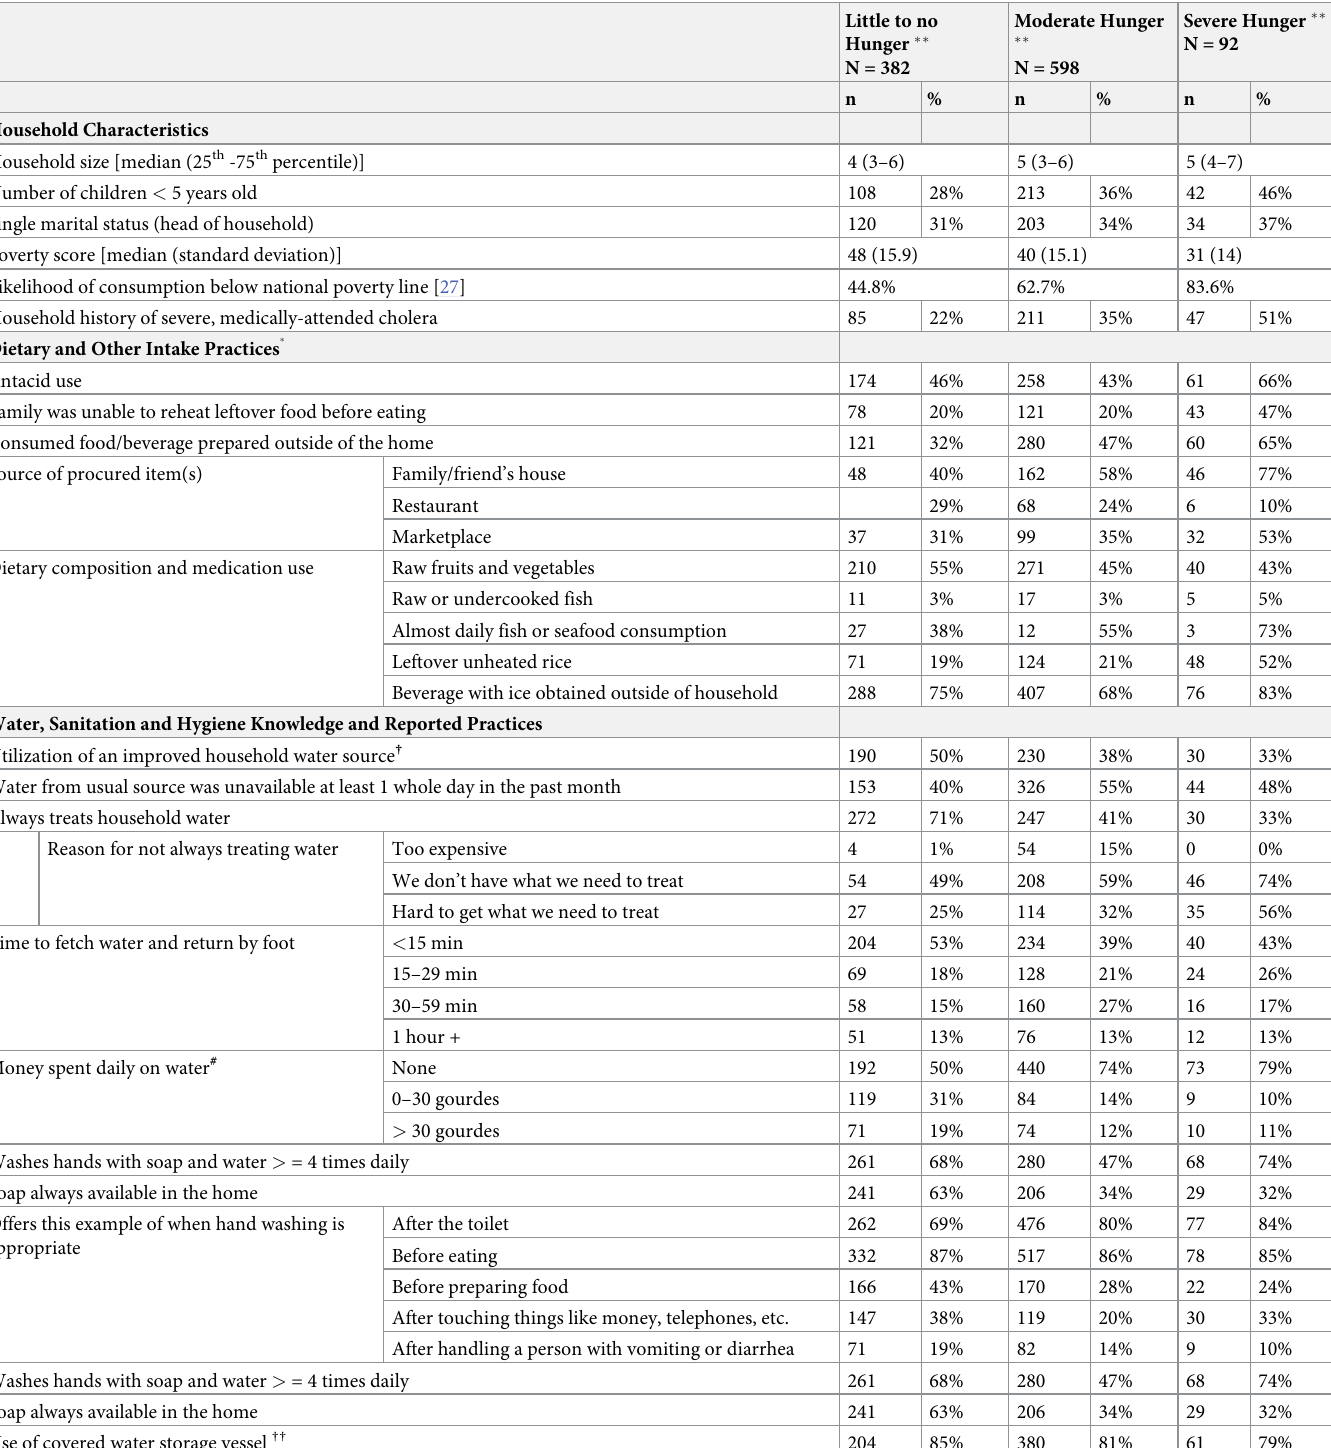
Table 1. Household characteristics, dietary, food, and hygiene practices and knowledge of cholera in a cross-sectional household survey of Mirebalais, Haiti 2019 (N = 1072).